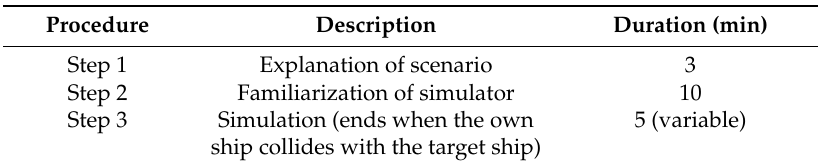
Figure 5. Example of a navigator’s maneuvering behavior to avoid a collision. Table 3. Simulation